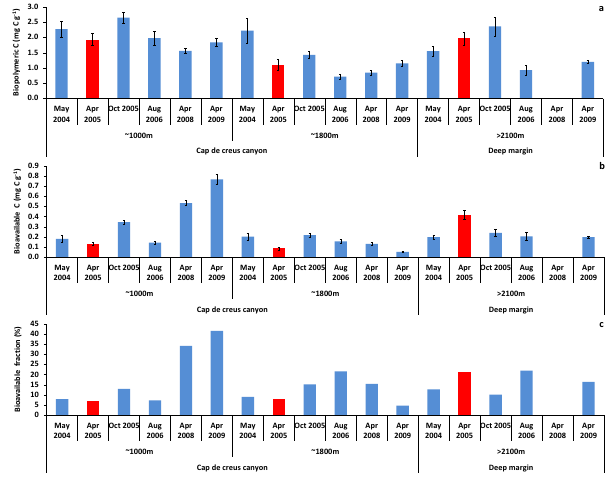
Fig. 2. Spatial and temporal variation in the sedimentary contents of biopolymeric C (a) , bioavailable C (b) and the bioavailable fraction of BPC (c) in the Cap de Creus Canyon and in the deep margin. Red bars indicate Pusceddu et al. Major consequences of an intense Dense Shelf Water Cascading event on deep-sea benthic trophic conditions and meiofaunal biodiversity